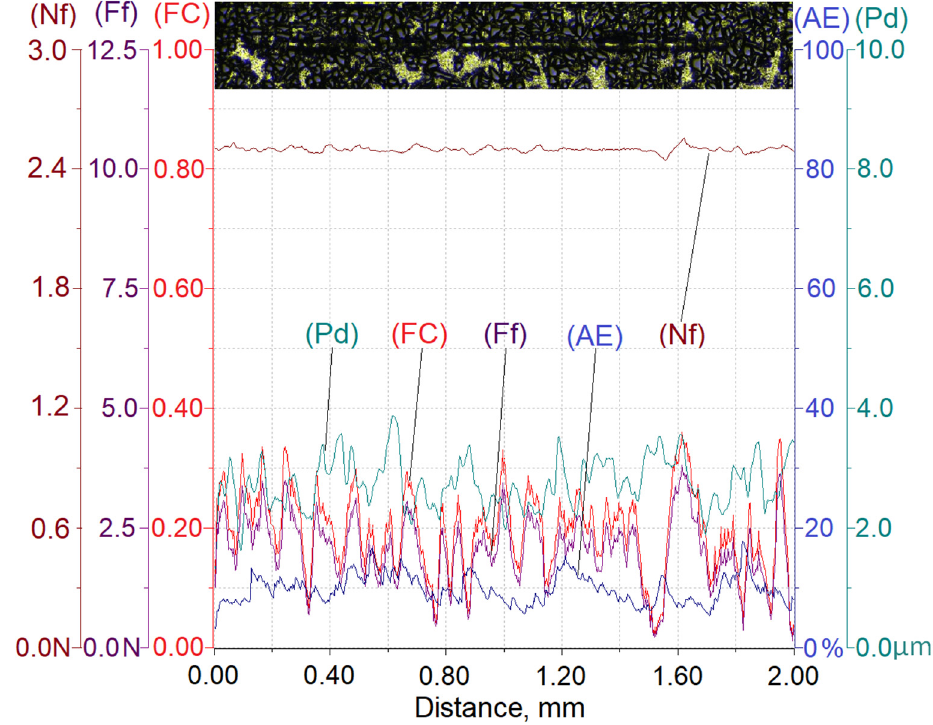
Figure 8. Results of AlSi12 / SiC p composite layer scratch testing for the normal load force Nf = 2.5 N; Nf—normal force, Pd—penetration depth, Ff—frictional force, FC—friction coefficient, AE—acoustic emission.